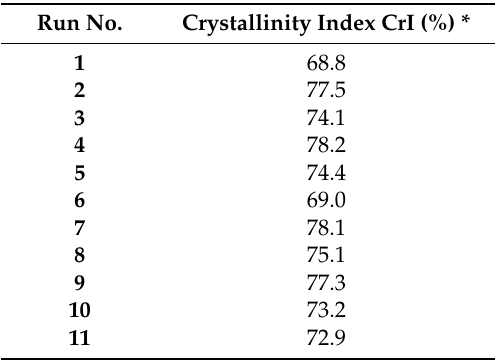
Table 3. Crystallinity index (CrI) of pretreated